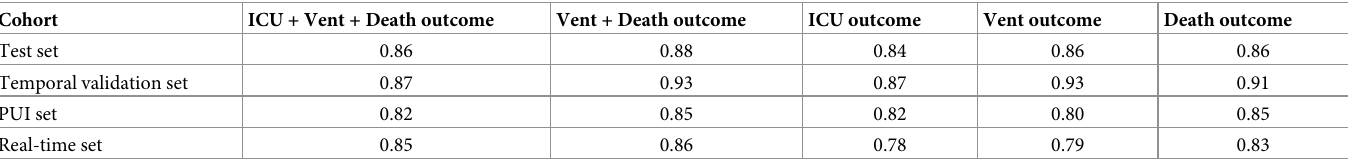
We developed and implemented a ML-enabled model to predict increased risk for COVID-19 severity to support the ED physicians’ clinical decision-making across our 12-sites medical sys- tem. Despite the significant variabilities of the factors, our model performed well in a large PUI study population. This approach is beneficial for clinical decision-making in ED where the COVID-19 PCR test results are inconsistently resulted. Importantly, we evaluated our model real-time in PUI patients seeking acute care in ED after the score became available in the EHR and the model performance remained strong. The difference in ICU admission rate, ventilator use, and mortality rate between the training set and the temporal, PUI, and real- time validation sets can be explained by the temporal improvement in COVID-19 patients’ outcomes that was noted in other studies [4, 32, 33]. The COVID-19 ICU admission and patient survival improved in our study over time as it did in other reports, perhaps because of Table 5. AUROC of all cohorts for predicting the individual and composite outcomes. Cohort Test set PUI